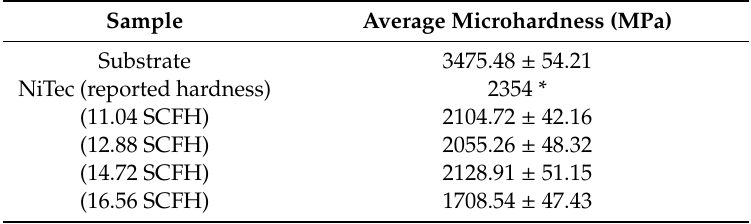
Table 2. Average surface microhardness of NiTec coatings.